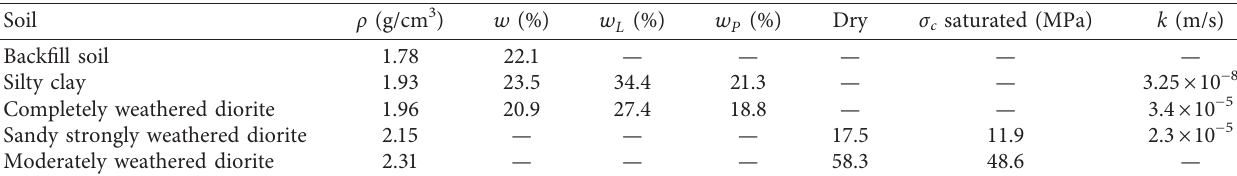
Figure 3: Geological section of a section of Jinan Metro line R2. A, backfill soil; B, silty clay; C, completely weathered diorite; D, sandy strongly weathered diorite; E, moderately weathered diorite. Table 2: Geological parameters of the interval